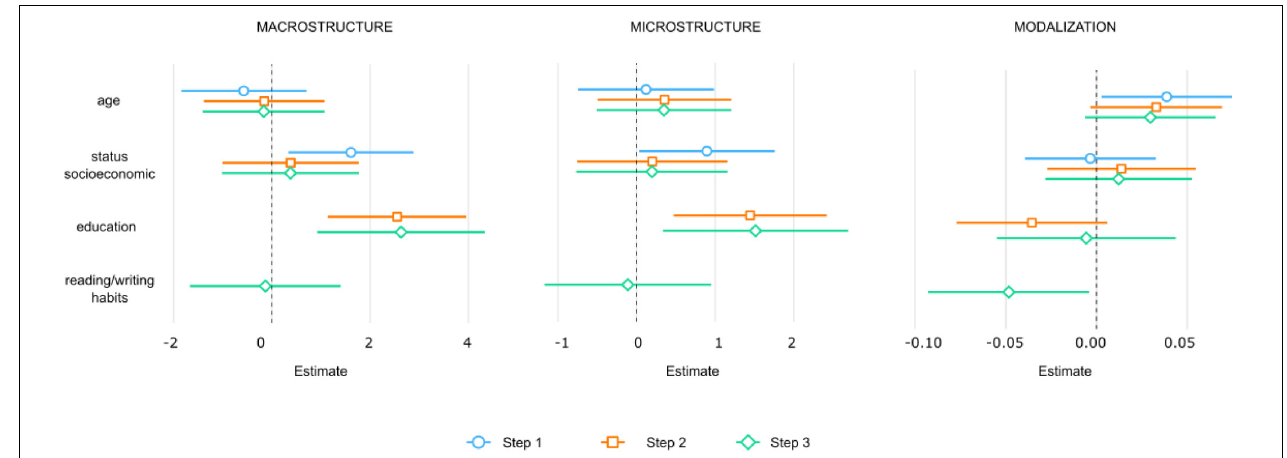
FIGURE 1 | Beta and confidence intervals for each regressor variable of the three hierarchical linear regression models (macrostructure, microstructure, and modalizations). The dots represent the beta, and the lines depict the confidence intervals for each regressor variable of the models.